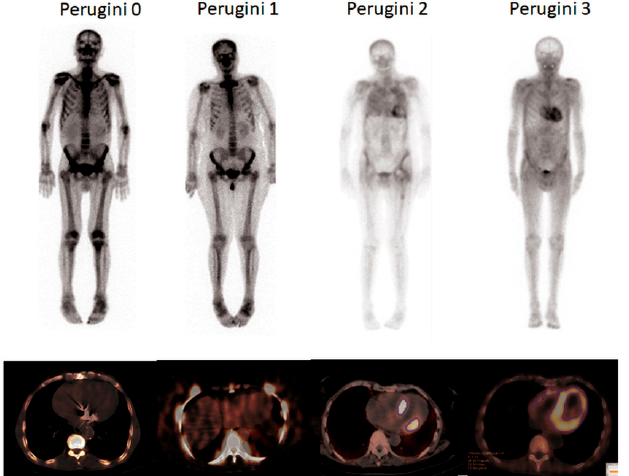
Figure 2. Patient examples for all four Perugini scores: This figure shows an example of a patient with every Perugini score.